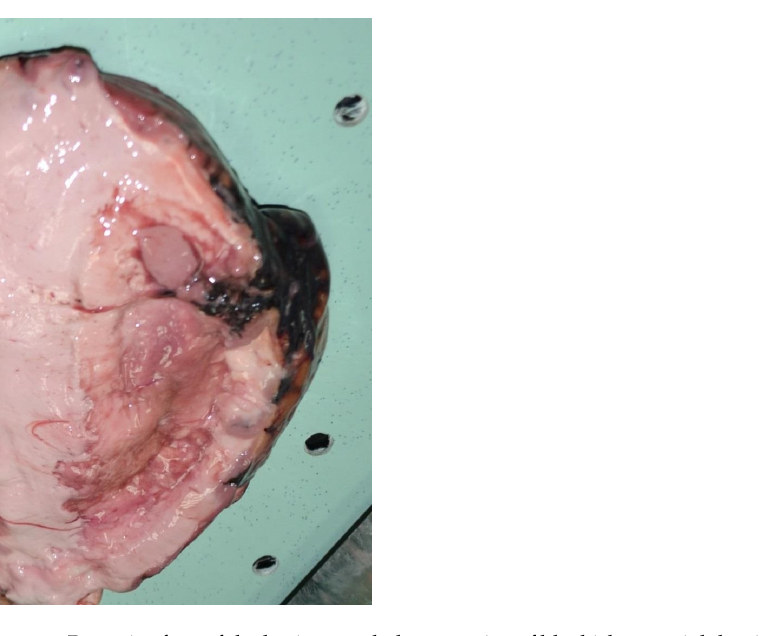
Figure 3. Posterior face of the brain revealed stem striae of blackish material that invaded the nervous tissue.